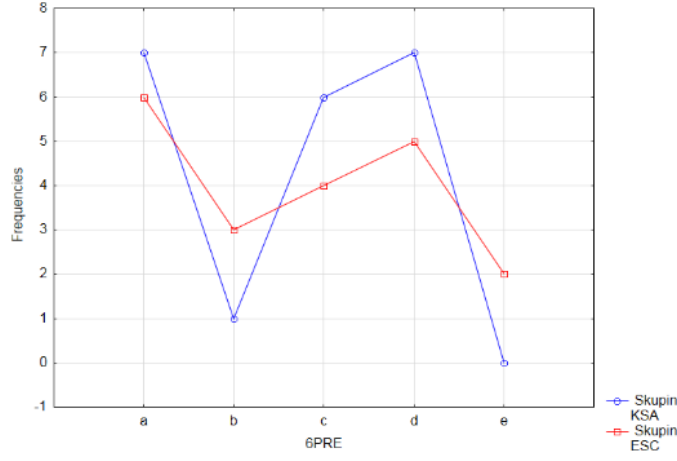
Figure 15. Interaction graph of the sixth item of the pretest - 6PRE.